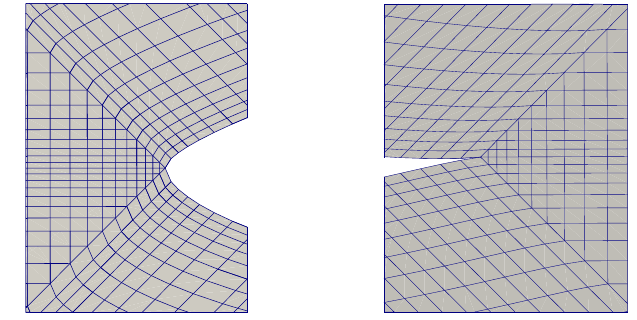
Figure 14. Detailed view of the fluid mesh at the leading edge and the trailing edge.